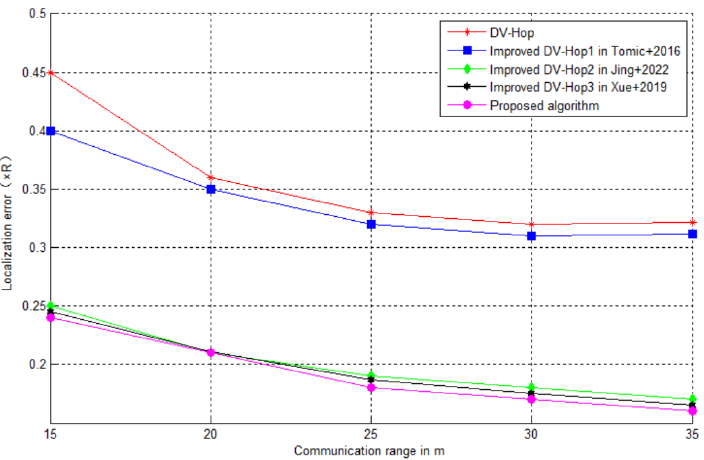
Figure 6. Comparison of localization errors in different communication radius [21–23].